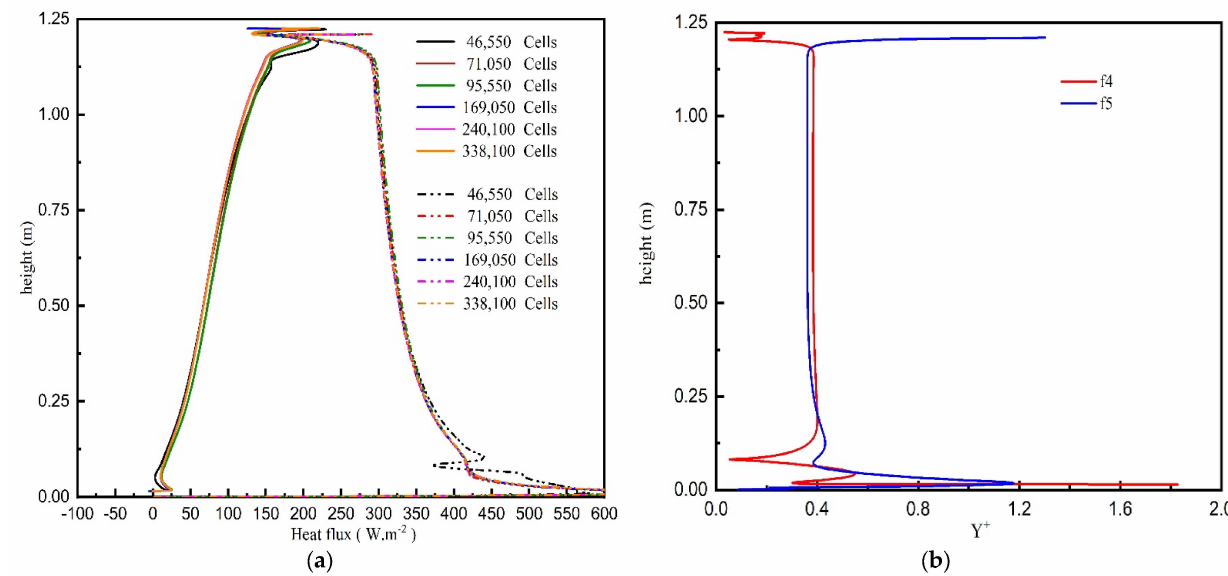
Figure 6. Numerical test showing curves of: ( a ) mesh independence results; ( b ) y+ values for faces 4 and